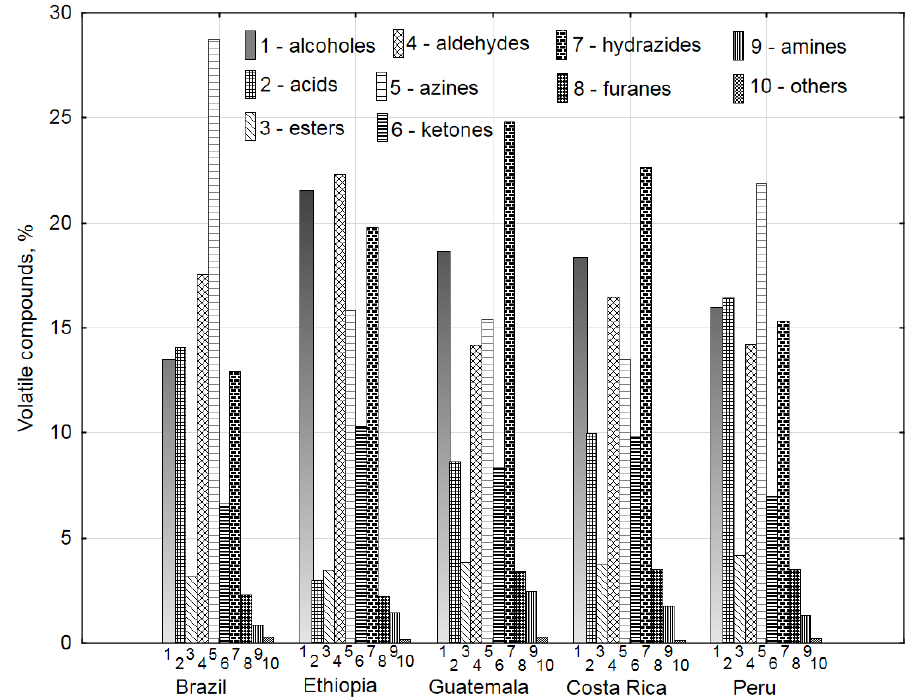
Figure 2. Percentage share of groups of volatile substances for all coffees beans after roasting .